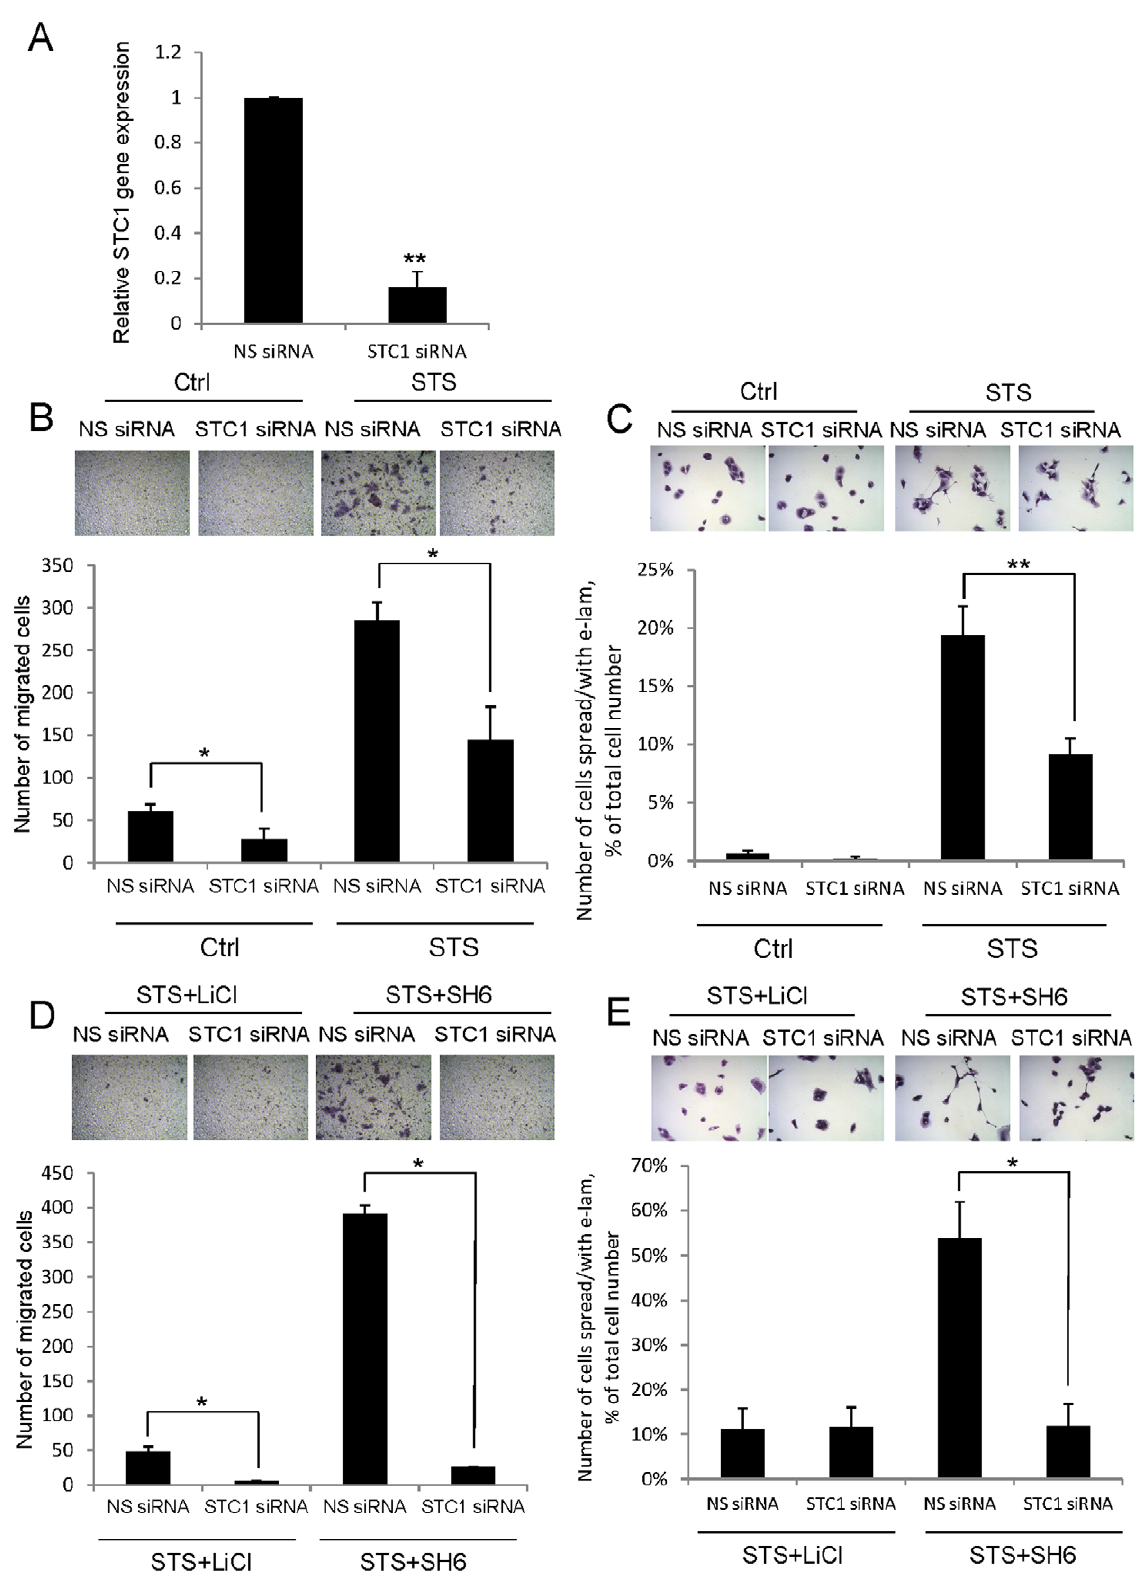
Figure 4. STC1 knockdown hinders STS-mediated re-epithelialization process. (A) After the transfection of STC1 siRNA for 48 h, the knockdown efficiency was examined by real-time PCR. In STC1 siRNA-transfected cells, STS-induced (B) cell migration and (C) e-lam formation on the fibronectin-coated plates were significantly reduced as compared to the NS siRNA-transfected cells. The cell images were captured for e-lam formation (200x magnification) and cell migration (100x magnification) ( top ). Under the STS + LiCl or STS + SH6 cotreatment, (D) the number of